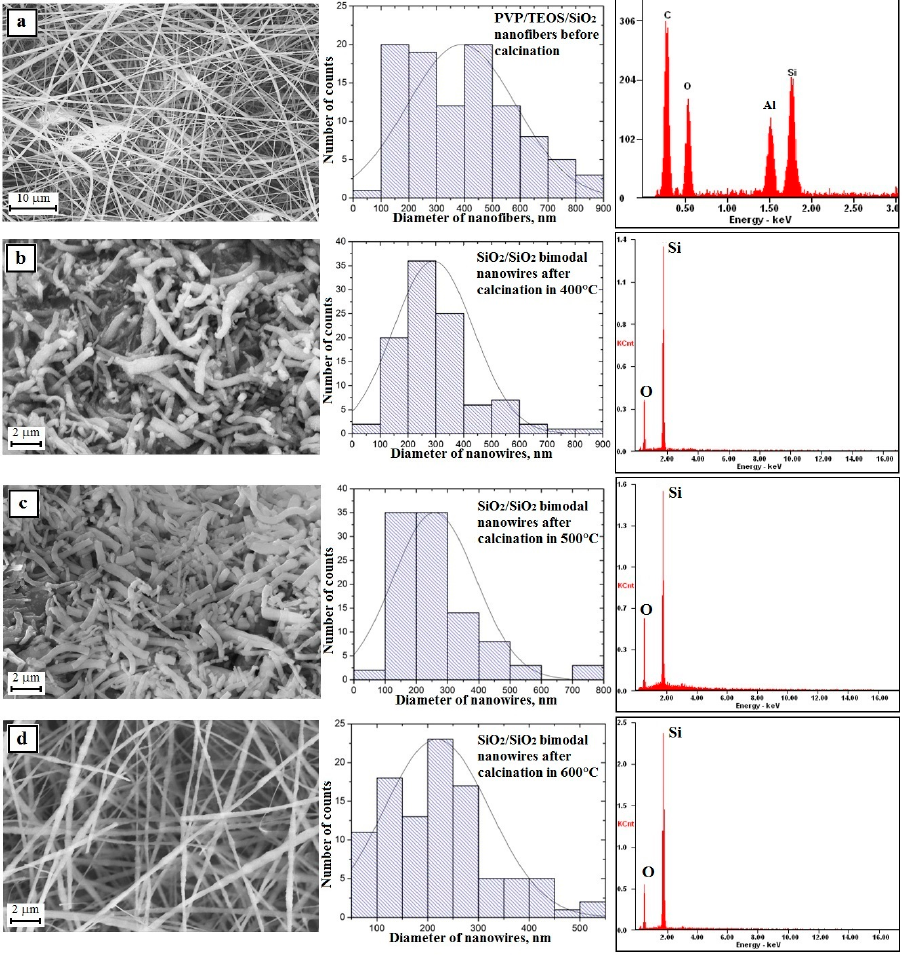
Figure 7. Left: SEM image of the topography on the surface of the formed fibrous composite mats, obtained nanowires; Middle: histograms presenting the distribution of hundredfold measurement of the diameter of randomly selected: ( a ) nanofibers obtained from PVP/TEOS/SiO 2 /H 2 O/AcOH/EtOH solution, ( b – d ) bimodal SiO 2 /SiO 2 nanowires after calcination in 400, 500 and 600 °C; Right: obtained EDS spectra (peaks of Al derive from the substrate on which nanofibers were deposited while Au and Pd derive from the conductive layer sputtered onto the produce nanostructures) from the entire area shown in the SEM images.